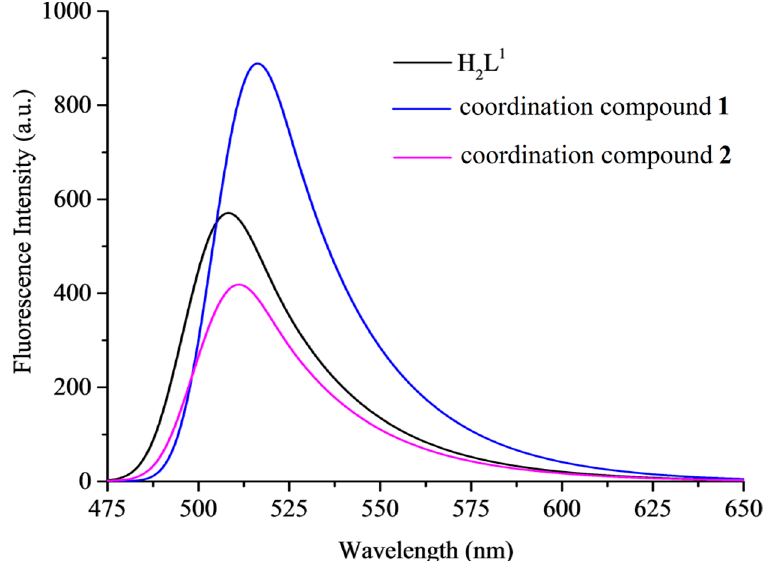
Figure 8. Emission spectra of H 2 L 1 ( λ ex = 328 nm) and its coordination compounds 1 and 2 ( λ ex = 386 nm) in CH 3 OH (2.5 × 10 − 5 M).